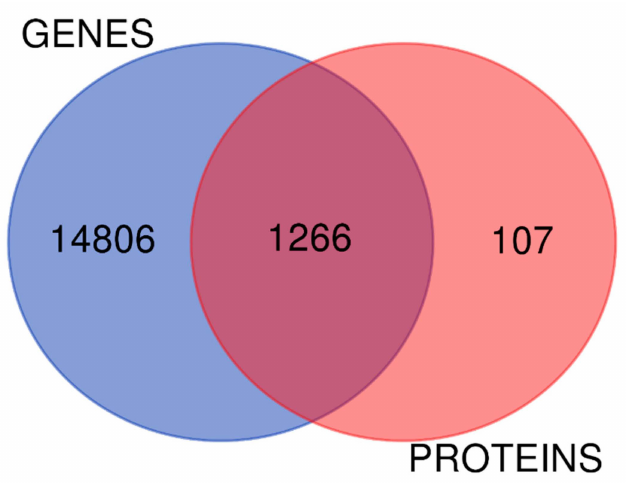
Figure 3. Venn diagram representing the set of identified proteins and the coding genes.